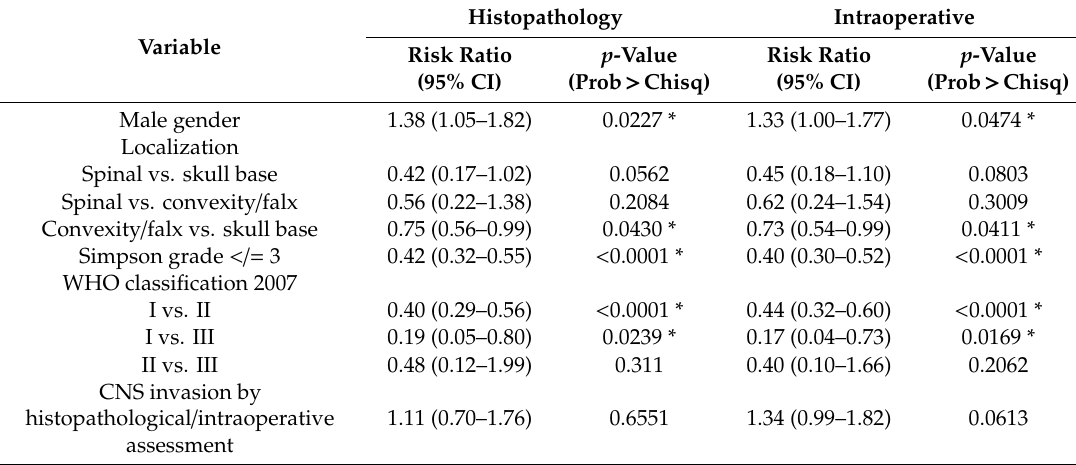
Table 2. Multivariate analysis of the histopathologically and intraoperatively assessed CNS invasion (Cox proportional hazard).